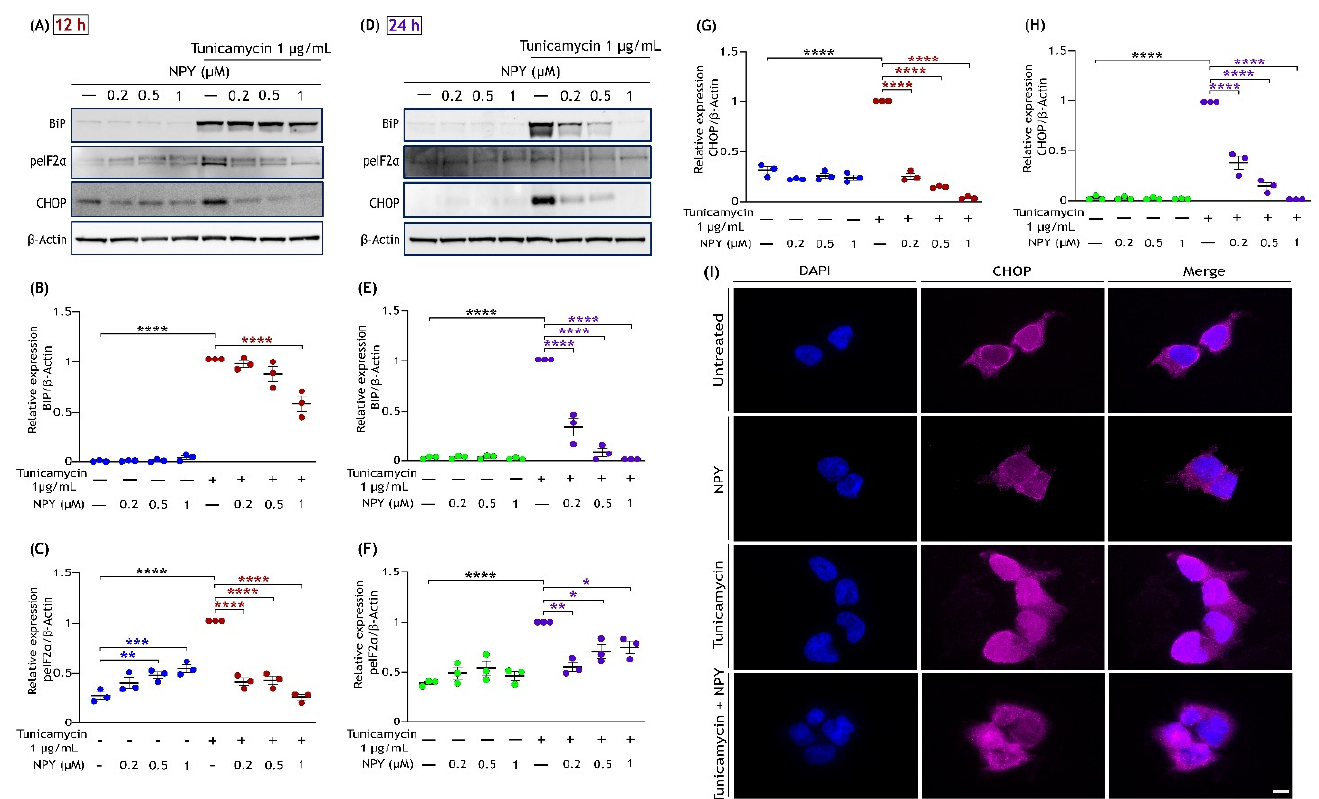
Figure 5. NPY treatment eases the ER stress induced by tunicamycin in SH-SY5Y cells. Western immunoblot illustrates that the tunicamycin-induced activation of ER markers such as BiP, phospho-eIF2 α (Ser51), and CHOP that are reduced with the NPY treatment (0.2 µM, 0.5 µM, and 1 µM) at 12 ( A ) and 24 h ( D ). Densitometric quantification of BiP at 12 ( B ) and 24 h ( E ) reveals a significant increase under tunicamycin compared to the control group (F(1,16) = 912.6 in Figure ( B ) and F(1,16)= 181.4 in Figure ( E ), **** p < 0.0001, n = 3) and a significant decrease in its expression with NPY treatment (F(3,16) = 10.72, **** p < 0.0001 represents significance between tunicamycin and tunicamycin + NPY in Figure ( C ) (red) and F(3,16)= 85.76, **** p < 0.0001 in Figure ( E ) (purple), n = 3). Densitometric quantification of phospho- eIF2 α at 12 ( C ) and 24 h ( F ) reveals a significant increase under tunicamycin compared to the control group (F(1,16) = 17.33 in Figure ( C ) and F(1,16)= 34.16 in Figure ( F ), **** p < 0.0001, n = 3) and a significant decrease in its activation with NPY treatment (F(3,16) = 20.23, ** p < 0.01, *** p < 0.001 represents significance between control and NPY group (blue), **** p < 0.0001 represents significance between tunicamycin and tunicamycin + NPY in Figure ( E ) (red) and F(3,16)= 5.350, * p < 0.05, ** p < 0.01 in Figure ( F ) (purple), n = 3). Densitometric quantification of CHOP at 12 ( G ) and 24 h ( H ) reveals a significant increase under tunicamycin compared to the control group (F(1,16) = 43.85 in Figure ( G ) and F(1,16)= 351.1 in Figure ( H ), **** p < 0.0001, n = 3) and a significant decrease in its expression with NPY treatment at 12 h and 24 h, respectively (F(3,16) = 243.6, **** p < 0.0001 represents significance between tunicamycin and tunicamycin + NPY in Figure ( G ) (red) and F(3,16)= 129.5, **** p < 0.0001 in Figure ( H ) (purple), n = 3). Each band intensity was normalized to the respective band intensity of β -actin. ( I ) Immunofluorescence images (representative) of treated SH-SY5Y cells showing the expression of CHOP. After 12 h of treatment, cells were fixed and immunostained with an anti-CHOP antibody (pink). Nuclei were stained with DAPI (blue). Scale bar = 10 µm.